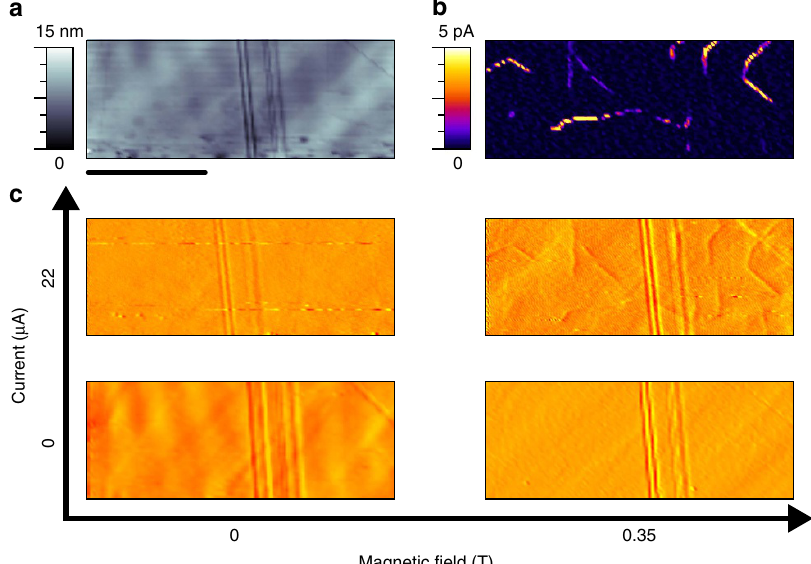
Figure 3 | Microscopy map of Hall voltage at conducting domain walls. ( a ) Contact mode atomic force microscopy (AFM) topography map and ( b ) associated current map within the interelectrode gap, showing a distinct pattern of conducting domain walls without any obvious topographic contrast. ( c ) Derivative of tapping mode AFM topography images taken under different conditions of magnetic field and source-drain current. Domain wall signals are only observed when both lateral current and a transverse magnetic field are applied, suggesting that the additional domain wall contrast is Lorentz-force mediated. Comparison with current map, b , confirms strong spatial correspondence. Scale bar, 5 m V H B 30 mV, | B | B 0.3T, assuming that the carriers are singly charged and that the current of | I | B 22 m A is shared among B 10 domain walls acting in parallel, each of width B 10 nm, a carrier density of order n B 1 (cid:2) 10 16 cm (cid:3) 3 can be obtained. Since cur- rent is not entirely restricted to the domain walls, this is likely to be a significant overestimate.